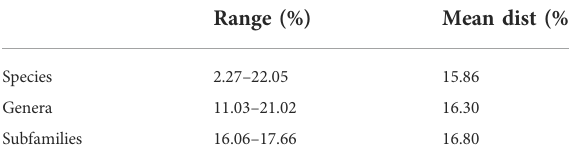
TABLE 2 The genetic distances (K2P) at various taxonomic levels in